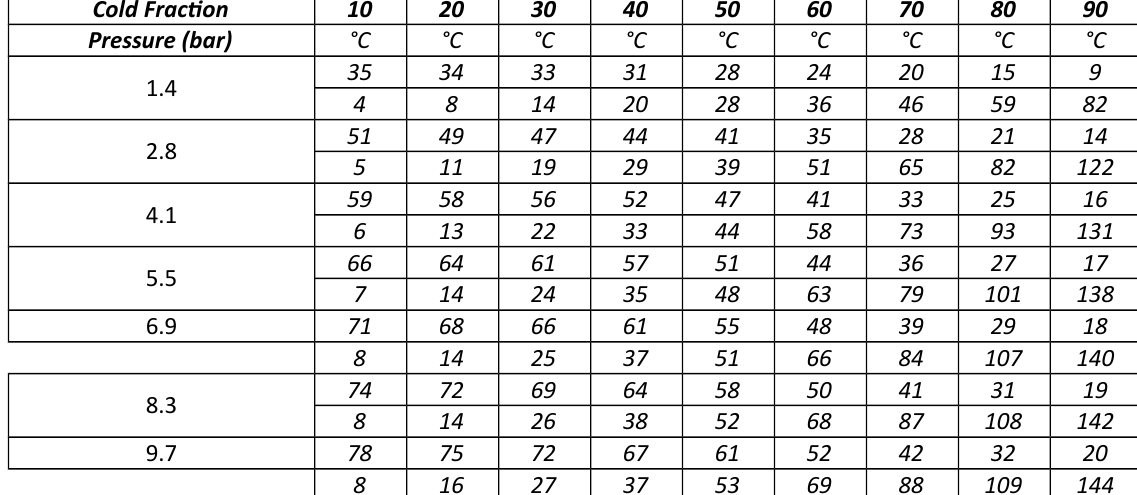
Table 2. Cold fraction and temperature change between the cold and the inlet flows (in blue) and the hot and the inlet flows (in white) for various